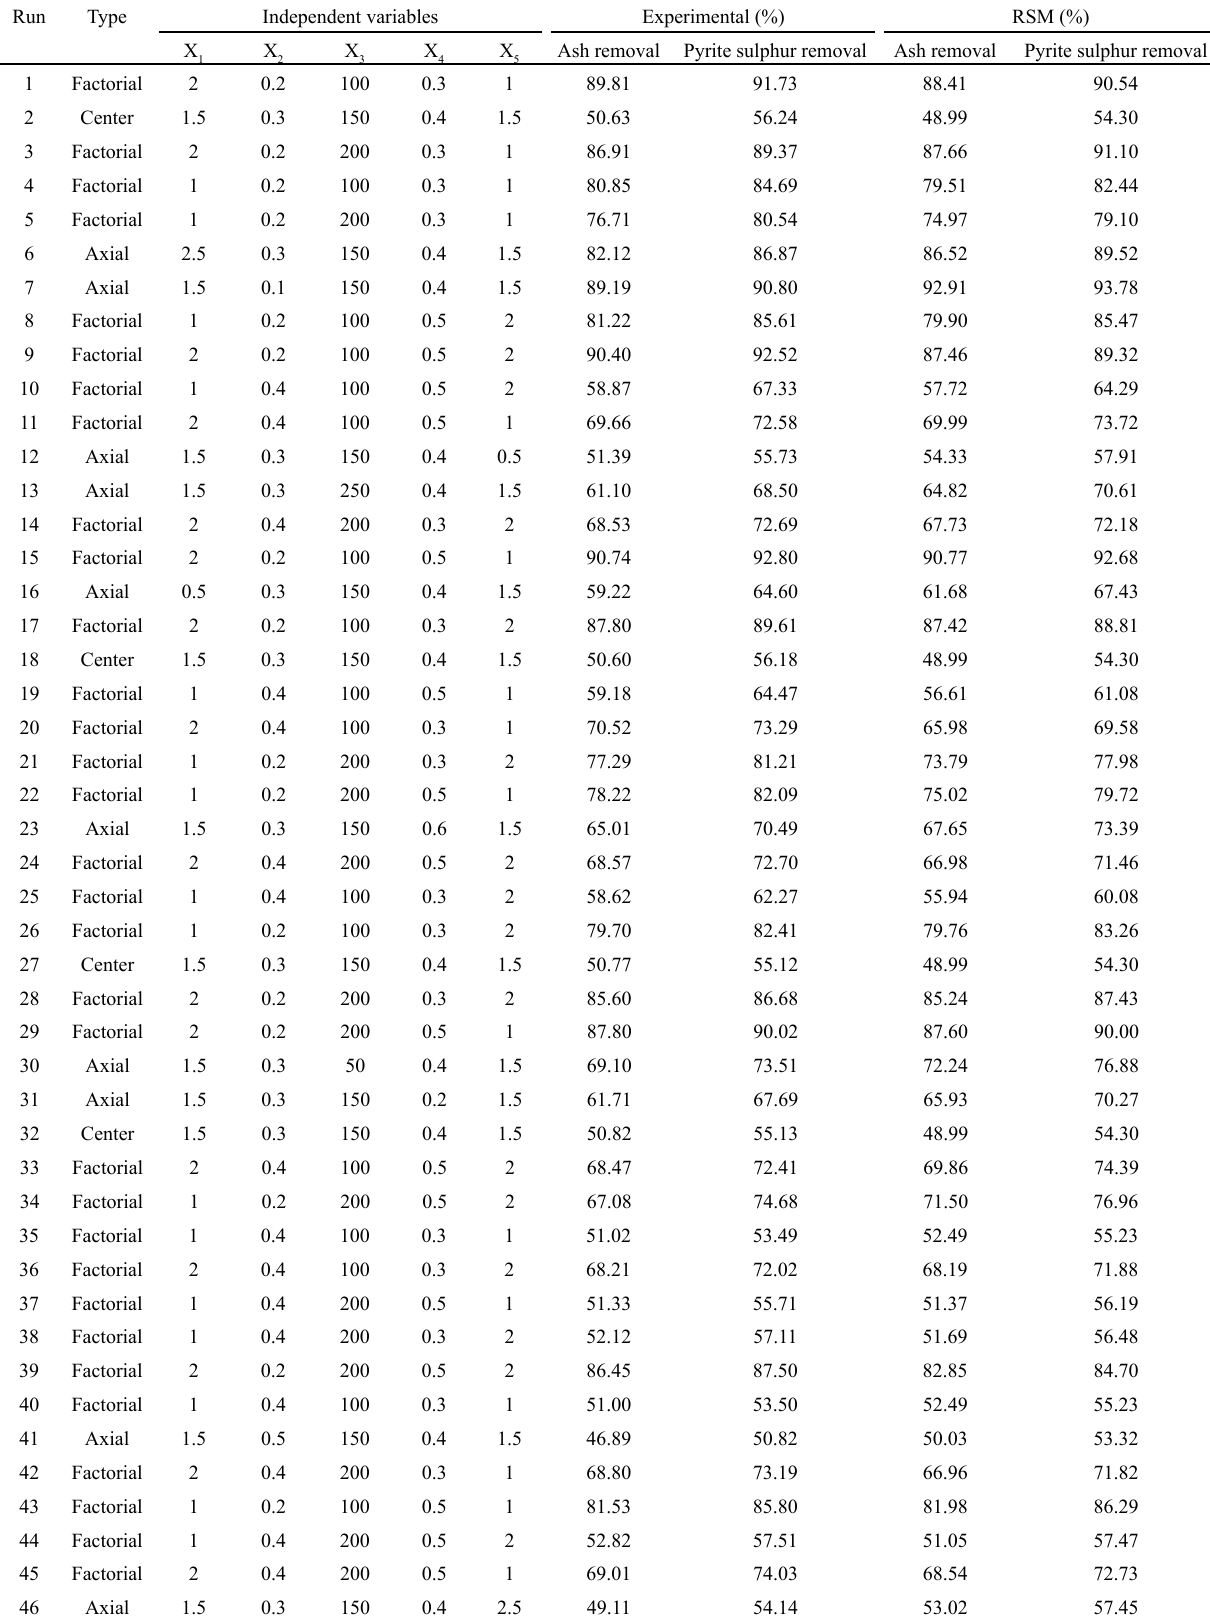
CCD with experimental and predicted